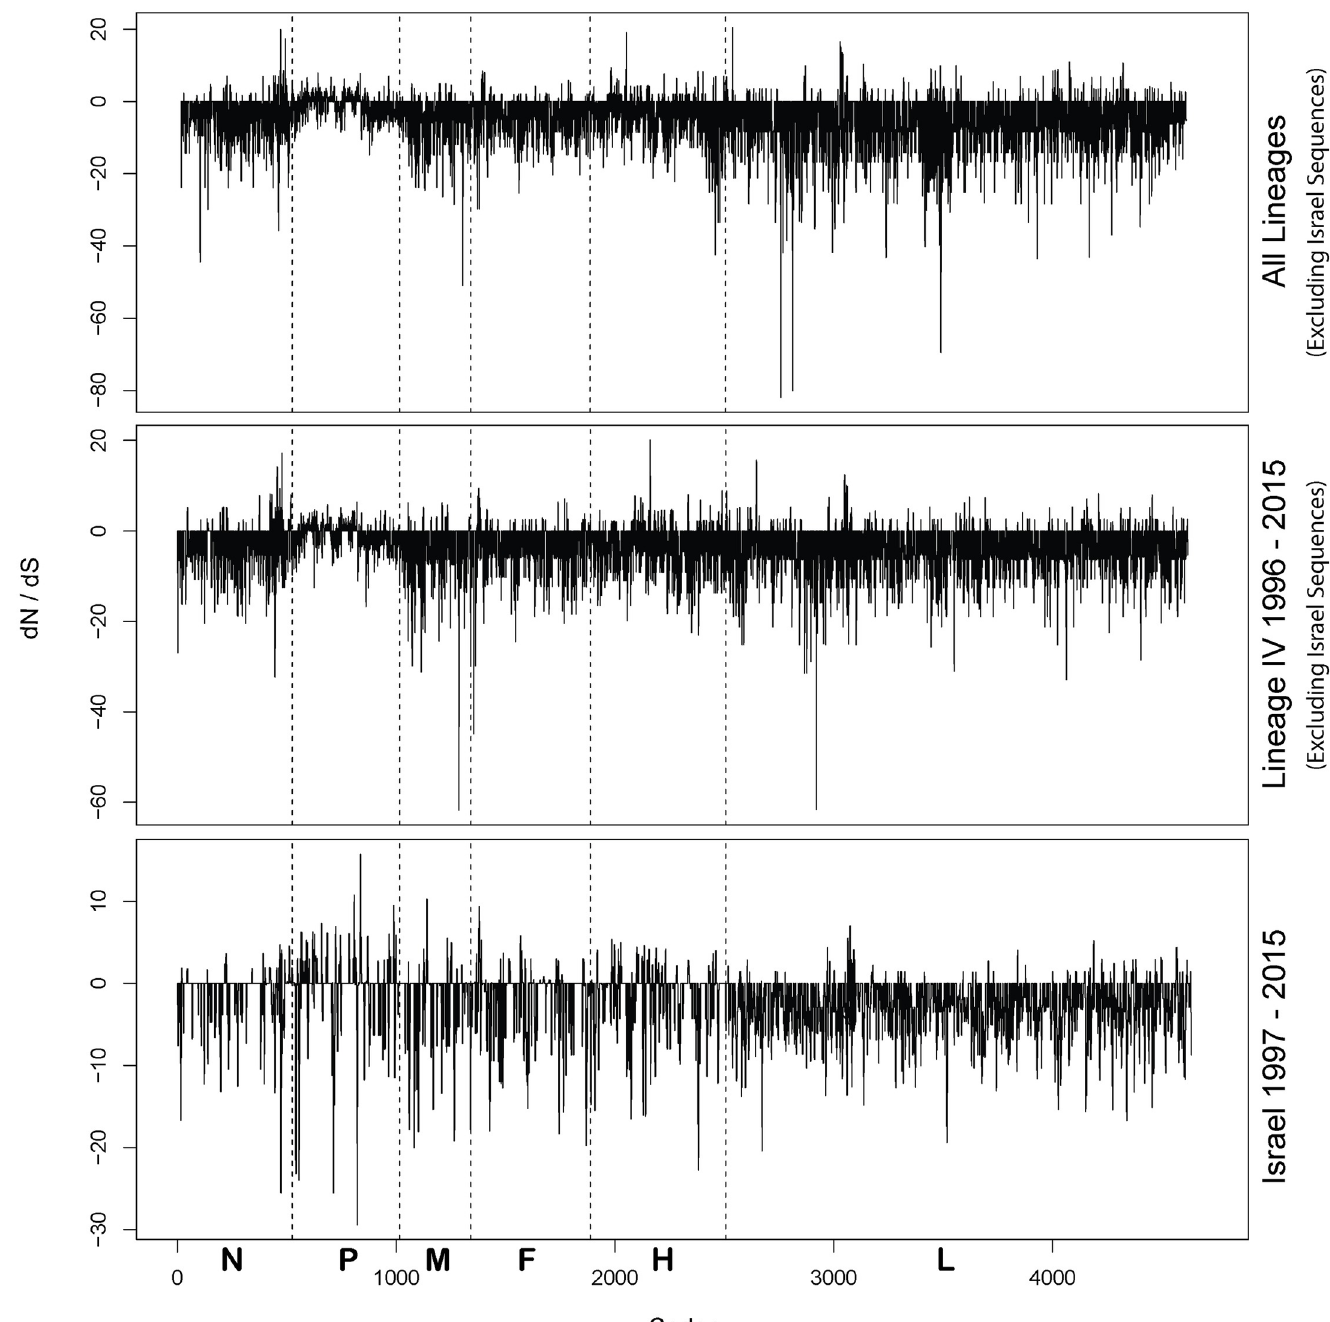
Fig 2. Mean ratio of nonsynonymous (dN) to synonymous (dS) substitutions for each site in the coding regions of PPRV. Proportionsof dN and dS were calculatedusing the single-likely ancestor counting method [45]. Dashedlines indicategene boundaries.